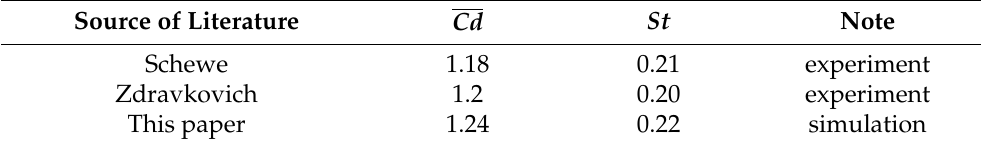
Table 4. Comparison of related parameters.